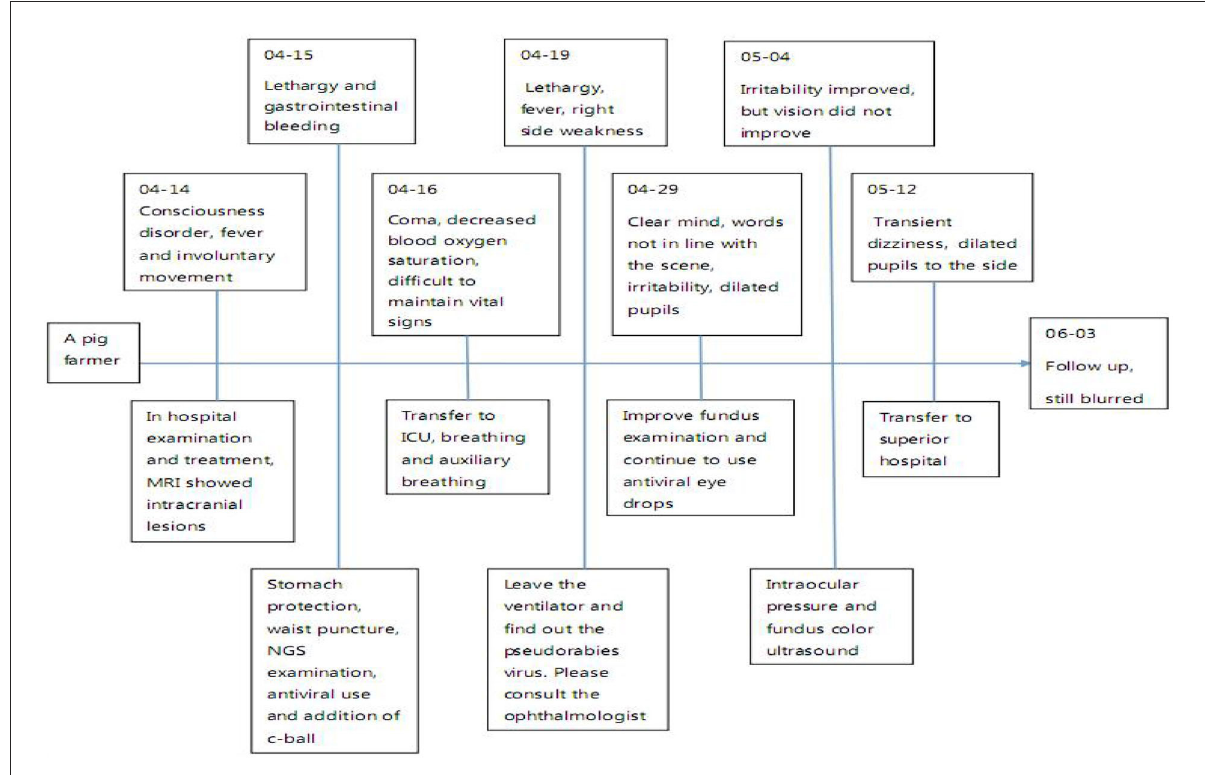
FIGURE3 Timeline figure of the clinical